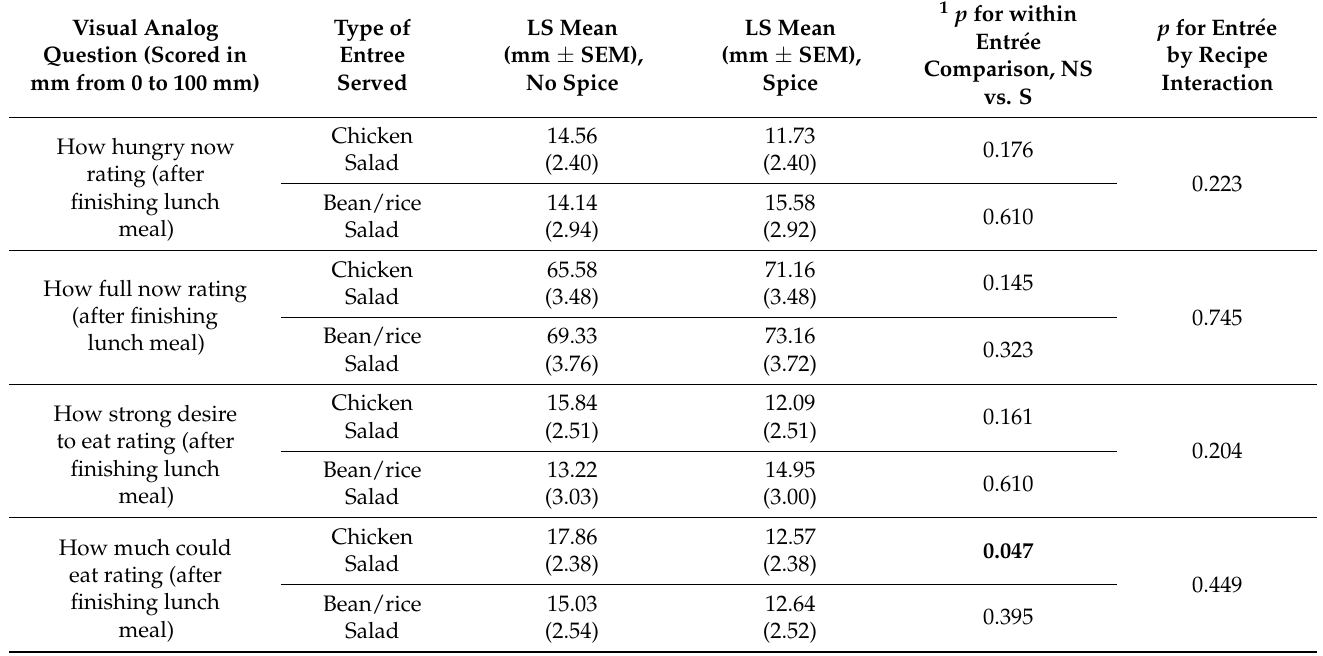
Table 4. Appetite